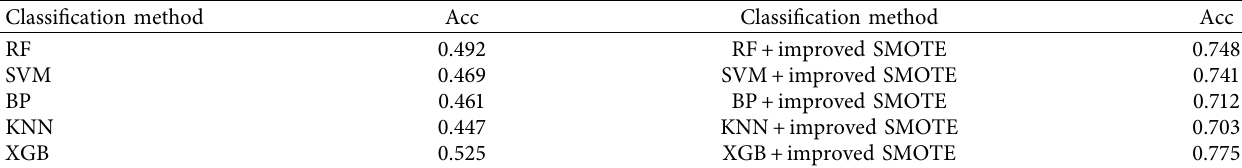
Figure 2: Data balance processing comparison. Table 3: Comparison before and after